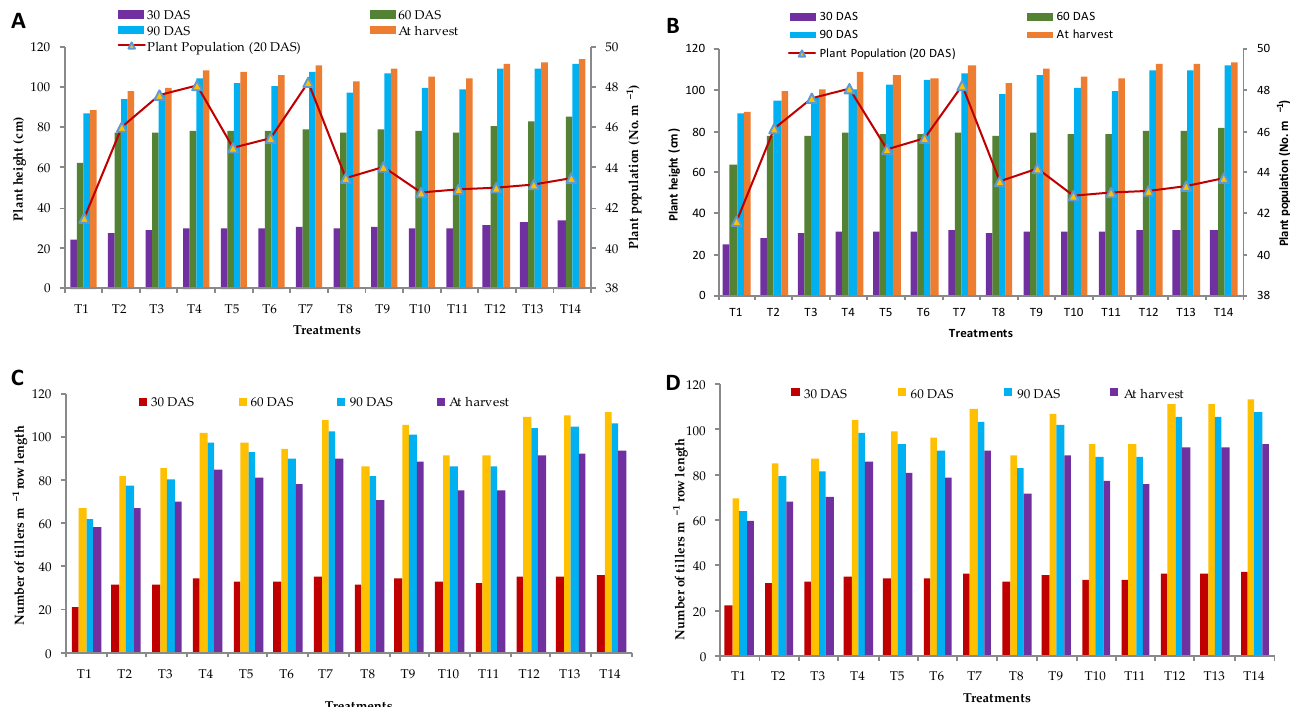
wheat (34.2 and 32.2 cm) were measured with the application of nutrient management under T-14, which, in the first year of the study, was comparable to T-13 and T-12 and, in the second year, was vastly superior to the other treatments., where all the treatments were at par with each other except control and suggested NPK (Figure 3). At the 60-day stage, the plant’s maximum height (85.3 cm and 81.6 cm) was obtained with the T -14 treat- maximum height (85.3 cm and 81.6 cm) was obtained with the T-14 treatment, which was ment, which was much better than the other treatments. During both years, with the ex- much better than the other treatments. During both years, with the exception of control ception of control plots, all treatment variations in plant height were comparable. Plant plots, all treatment variations in plant height were comparable. Plant height was higher height was higher than authorized NPK at harvest in 2017 – 2018 (18.2%) and 2018 – 2019 than authorized NPK at harvest in 2017–2018 (18.2%) and 2018–2019 (17.8%). However, (17.8%). However, only T-14-based applications at all phases during the two years showed only T-14-based applications at all phases during the two years showed a considerable a considerable rise. At all growth phases, nearly the same tendency was seen. The control rise. At all growth phases, nearly the same tendency was seen. The control plots produced plots produced shorter plants at all growth phases and significantly reduced plant height shorter plants at all growth phases and significantly reduced plant height (Figure 3). (Figure 3).